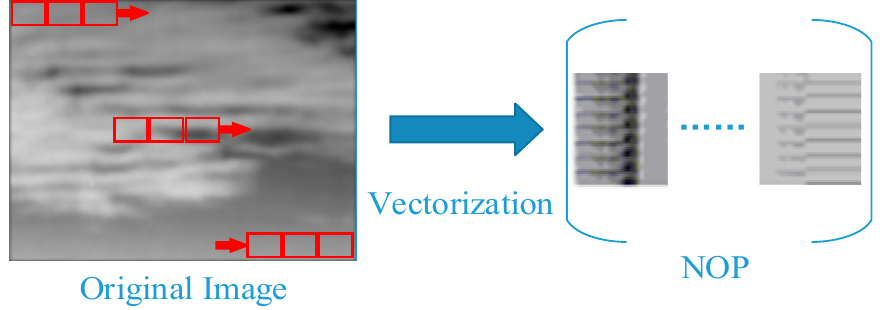
Figure 1. Construction of the non-overlapping patch (NOP).